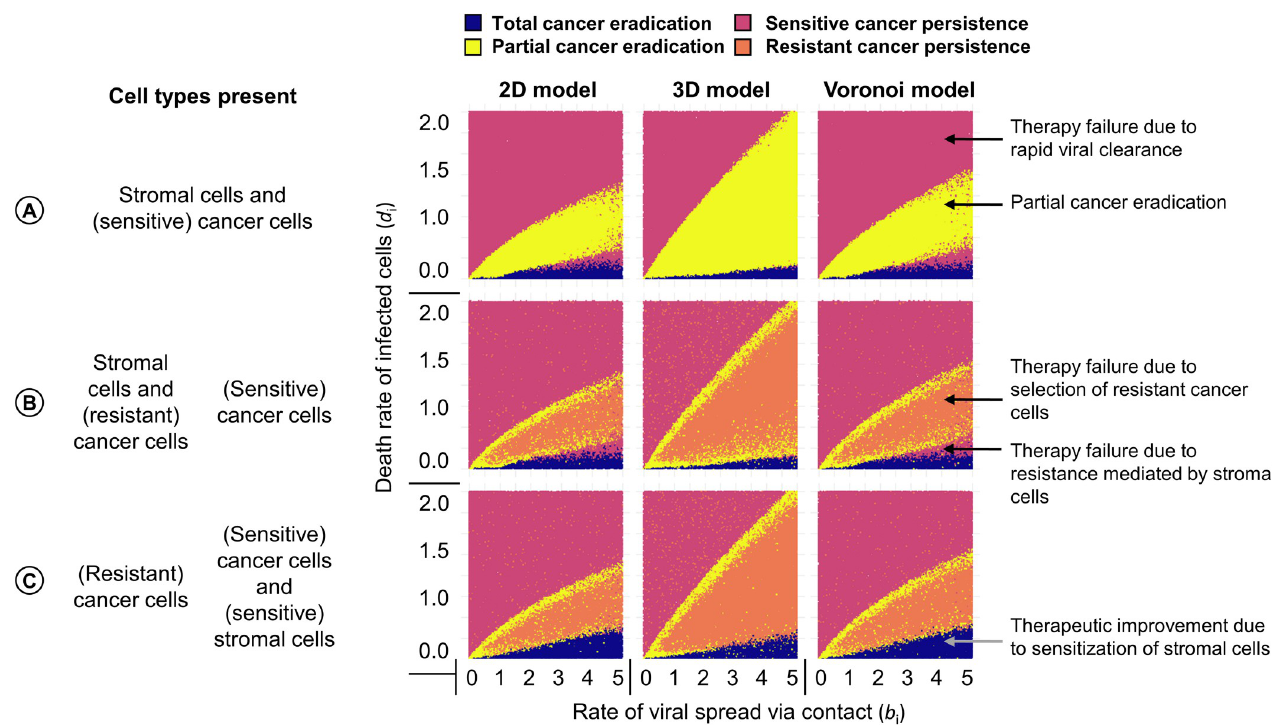
Fig 3. Effect of the rate of viral spread and death rate of infected cells on the outcome of virotherapy. For three scenarios: (A) absence of virus-resistant cancer cells; (B) production of resistant cancer cells with probability 10 − 5 per cell division; (C) presence of virus-sensitive stromal cells the panels show for three spatial configurations (regular 2D grid; regular 3D grid; 2D Voronoi tessellation) how the therapeutic outcome depends on the rates of viral spread ( b i ) and death rate of infected cells ( d i ). Each panel in the figure represents 100,000 simulations: for 100,000 parameter combinations ( b i , d i ) each simulation outcome is represented by a point, the colour of which indicates the therapeutic outcome. Due to stochasticity, neighbouring parameter combinations can differ in therapeutic outcome. The parameters under investigation were varied, keeping all other parameters at their default values (see Table 1).